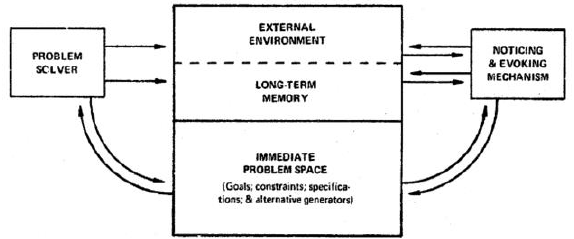
Figure 1. A model for ill-structured problems (Simon,